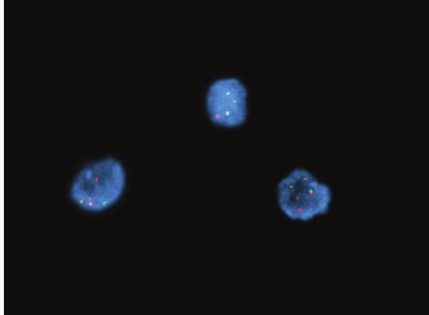
Figure 5: CD34 immunohistochemistry: sheets of monotonous CD34 positive blast cells (magnification × 400).